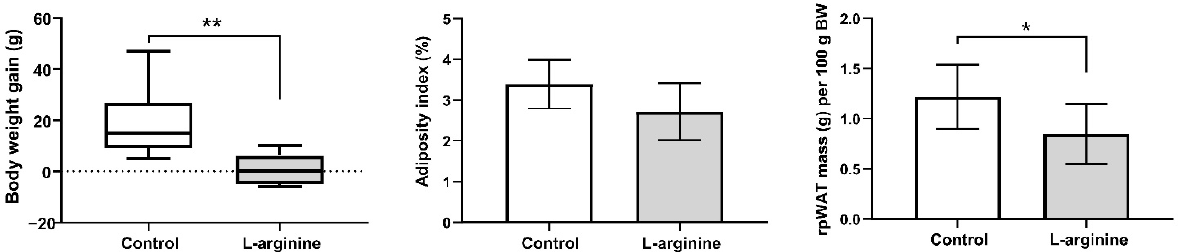
Figure 2. L -arginine reduces body weight gain and retroperitoneal white adipose tissue (rpWAT) mass. Body weight gain, adiposity index, and relative rpWAT mass of untreated (control) and L -arginine-treated rats; 2.5-month-old rats were randomly assigned to receive drinking water or 2.25% L -arginine · HCl in drinking water for 7 days. * Comparison with control; ( n = 6–8 per group); * p < 0.05; ** p < 0.01.